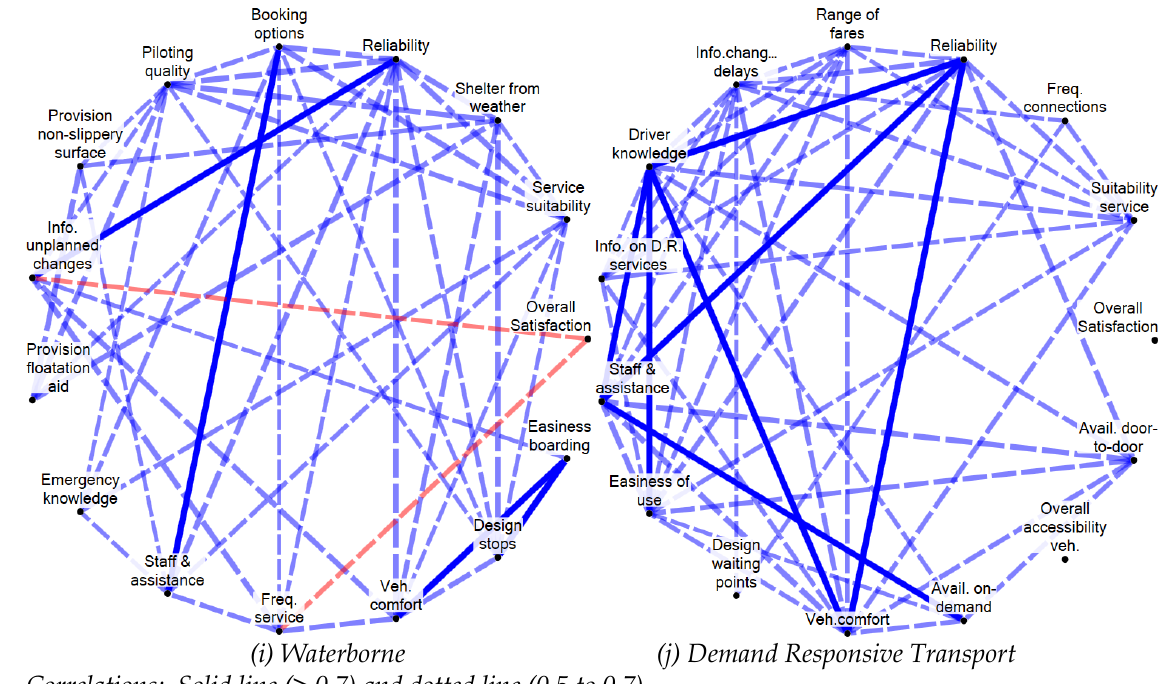
Figure 5. Cross-correlations among travel experience aspects and overall satisfaction on trip stages for different travel modes